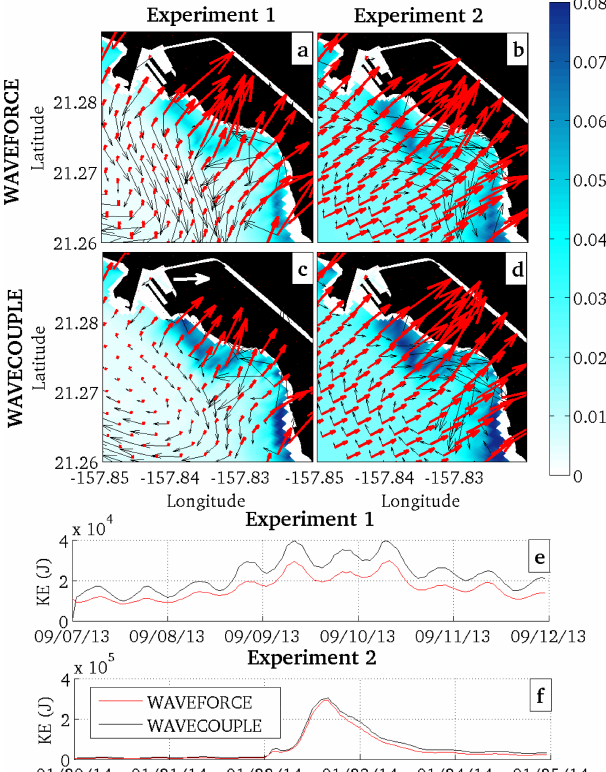
Figure 8. Maps of the time-averaged Stokes drift velocities (red ar- rows – ms − 1 ) and total surface velocities (black arrows – ms − 1 ) for the experiments 1 (a, c) and 2 (b, d) , and the associated time series of Stokes drift velocities kinetic energy ( e, f – J). The white arrow in panel (c) indicates a 10cms − 1 scale for the velocity vectors. Please note the difference in the vertical scale of panels (e) and (f)